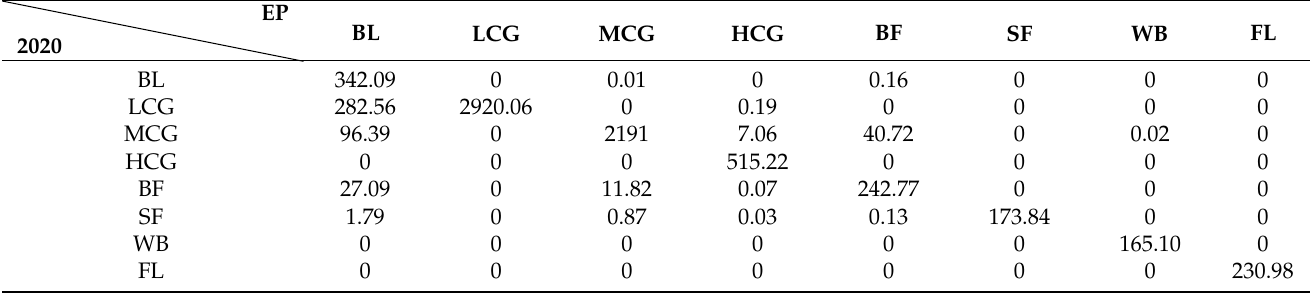
Table A10. Ecosystem service value changes from 2020 to 2030 EP (106